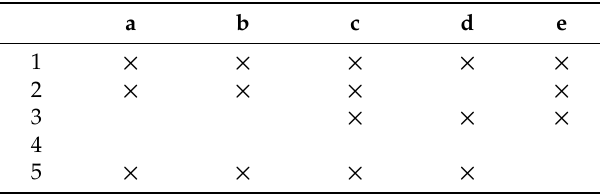
Figure 2. Concept lattice of the formal context in Table 1. Table 2. Example of the formal context after adding the attribute e